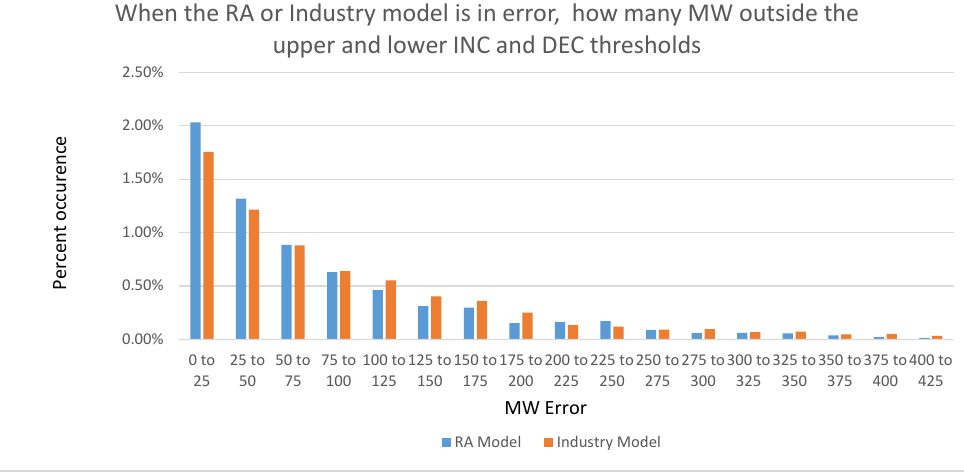
Figure 7. Test Results, Total Error and MW magnitude.